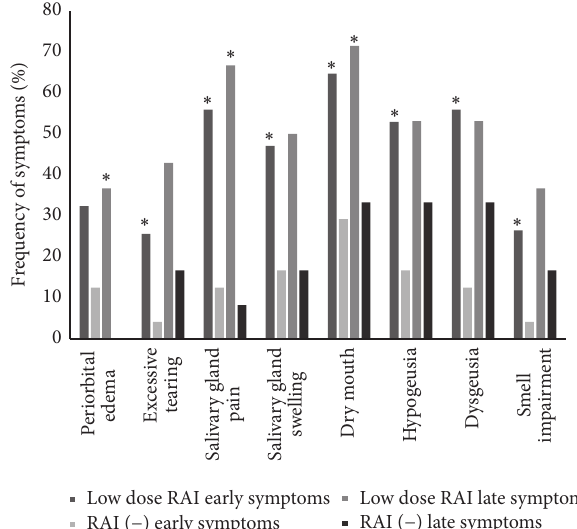
Figure 3: Frequency of early and late RAI related symptoms among patients who received low RAI dose ( ≤ 50mCi) and those who did not. ∗ shows statistically significant differences ( 𝑝 < 0.05 ) between patients who received low RAI dose and those who did